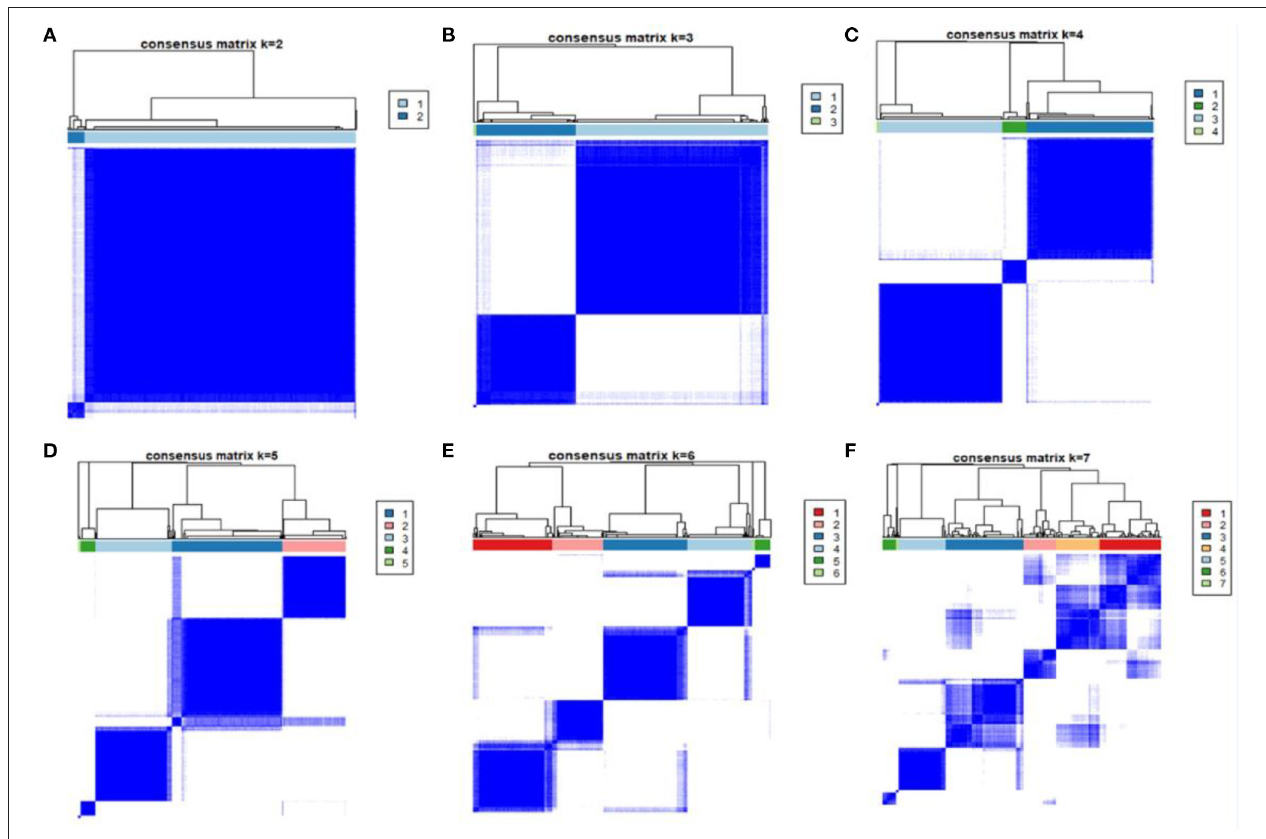
FIGURE 1 | Consensus matrix heatmaps of consensus k -means clustering. Consensus matrix heatmaps of different subgroup numbers ( k = 2, 3, 4, 5, 6, 7). When k = 3, the model exhibited the clearest separation of the consensus matrix heatmap.